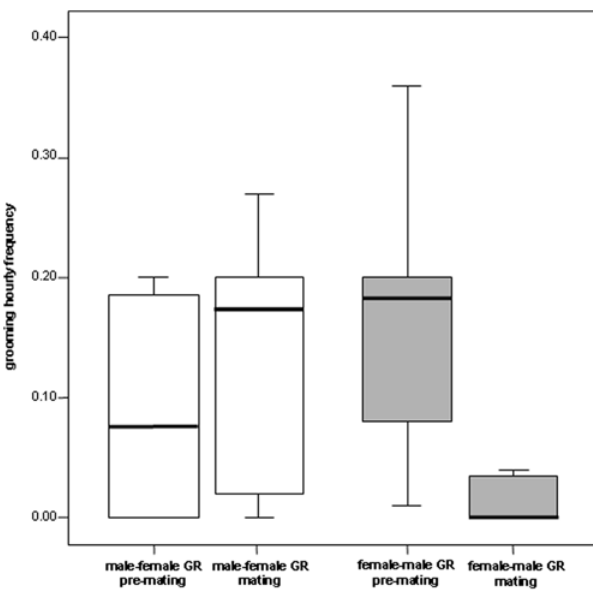
Figure 2. Grooming interchange. Variation in the levels of grooming directed from males to females and from females to males in the two periods (premating and mating).